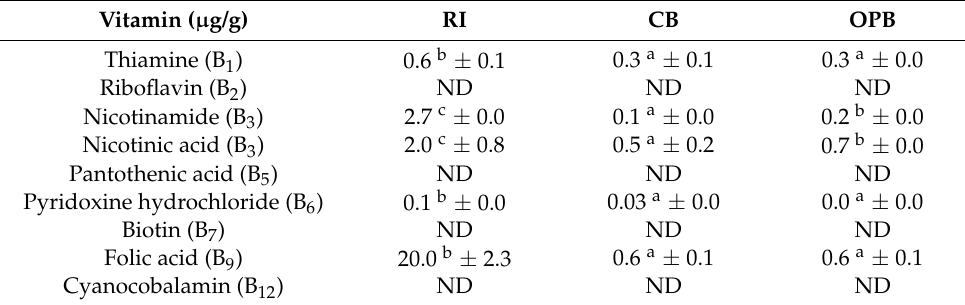
Table 4. B-group vitamin content in umqombothi